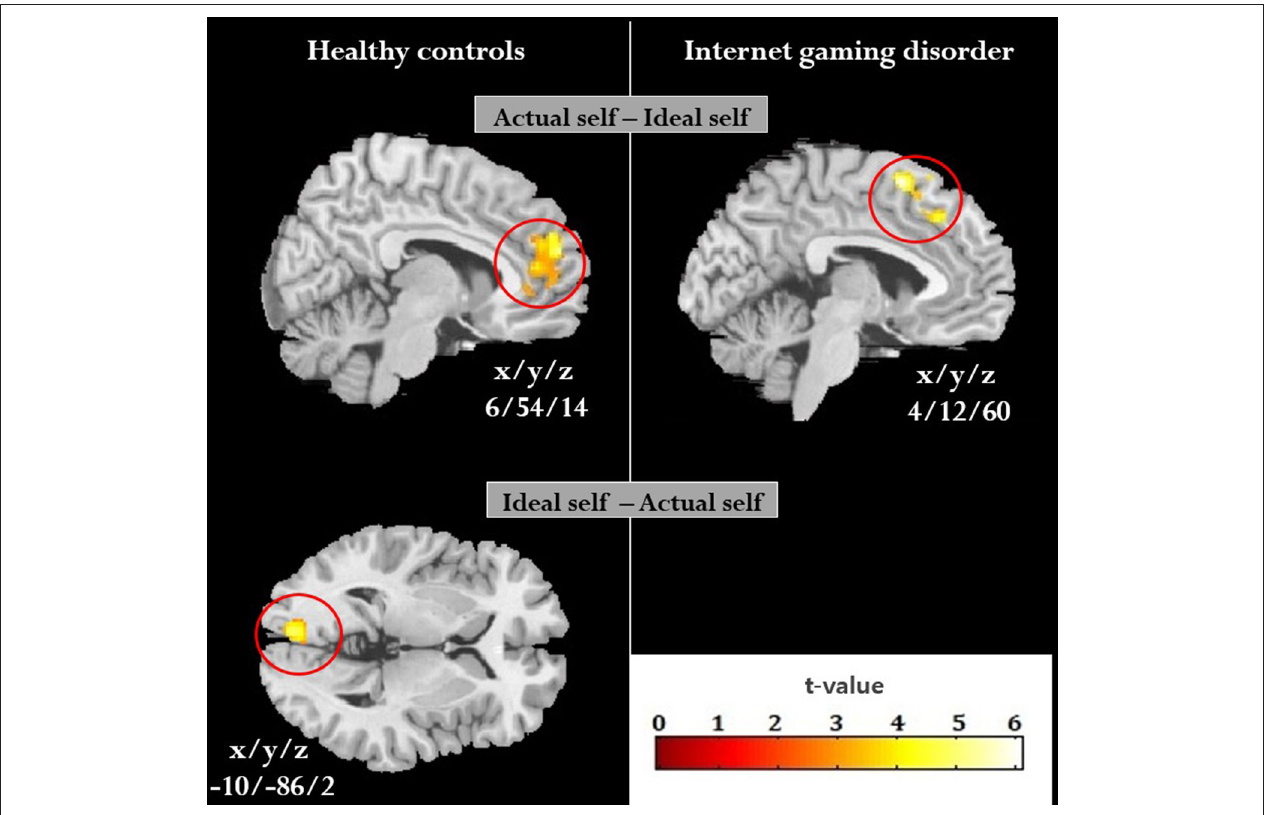
FIGURE 2 | Brain regions showing a significant difference in the comparison between the actual self and ideal self in each group. Increased activity in the actual self compared to the ideal self was found in the bilateral medial prefrontal cortex in healthy controls and the right medial prefrontal cortex in individuals with internet gaming disorder, whereas increased activity in the ideal self compared to the actual self was observed only in the left calcarine cortex in healthy